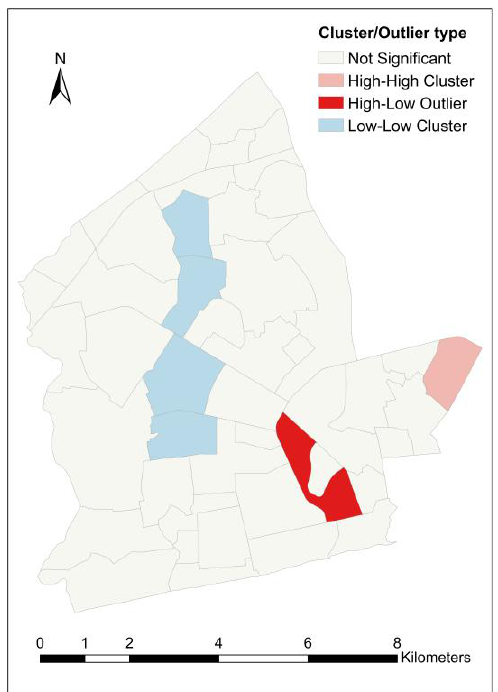
Figure 16. Cluster and outlier neighborhoods for ratio of load shedding exposure to population.